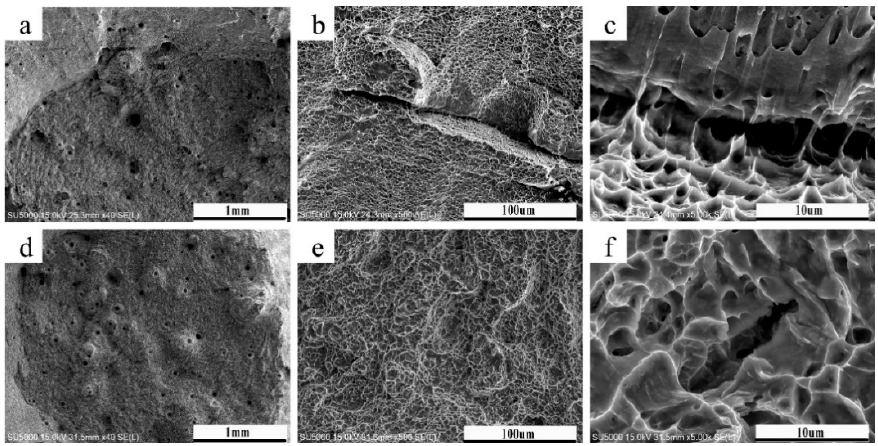
Figure 15. The macroscopic morphology of the fracture surface of the Ti-6Al-4V samples formed at different line offset: ( a – c ) samples with a line offset of 0.16 mm; ( d – f ) samples with a line offset of 0.28 mm.